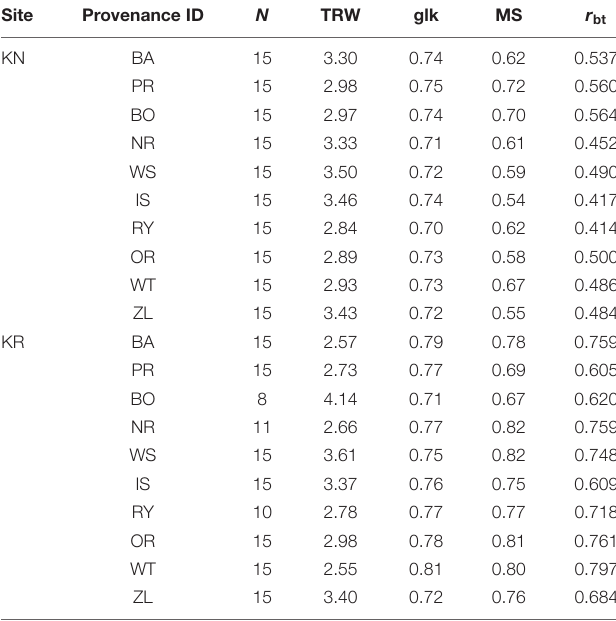
TABLE 3 | Chronology statistics of Norway spruce